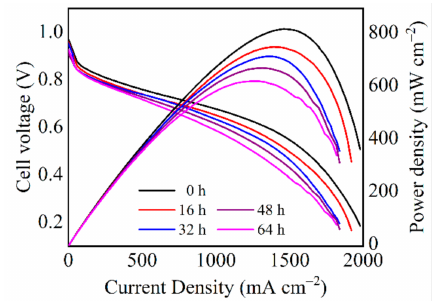
Figure 2. Polarization curves during the durability test.